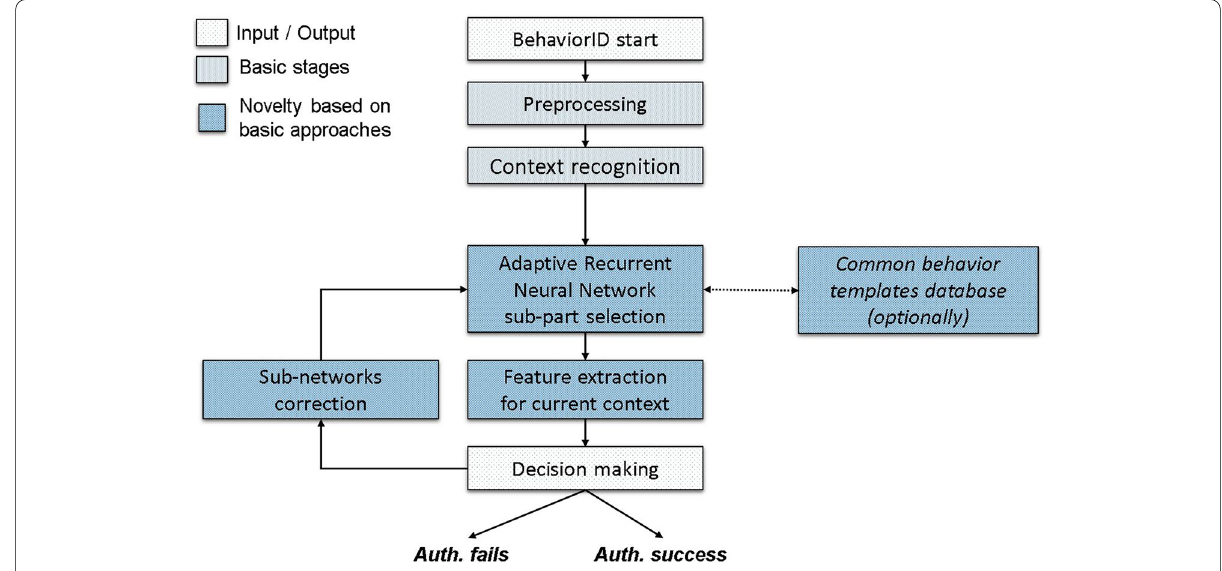
Fig. 2 User authentication procedure with proposed BehaviorID